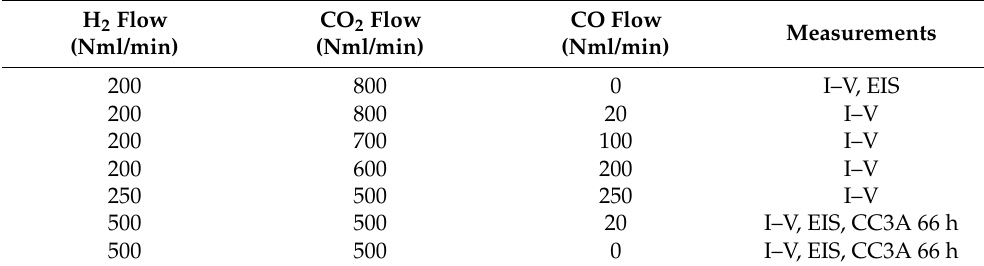
Table 2. Summary of measurements performed for various fuel compositions for investigation of presence of CO on cell performance; CC3A 66 h means constant current load of 3 A for 66